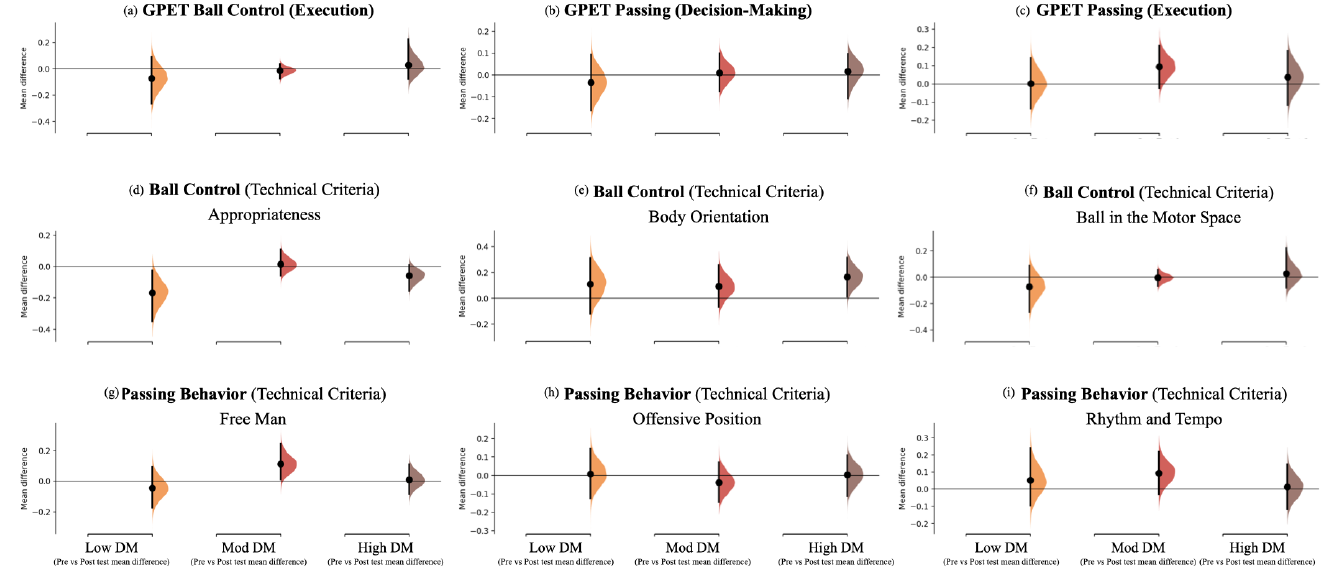
Figure 3. The mean difference (each mean difference is plotted as a bootstrap sampling distribution) for three comparisons pre- and post-measurements according to (i) GPET ball control, (ii) GPET passing execution, and (iii) GPET DM for the Low DM, Mod DM, and High DM tasks, as shown in the Cumming estimation plots above. The raw data are plotted on the upper axes. Mean differences are depicted as dots; 95% CIs are indicated by the ends of the vertical error bars [50].